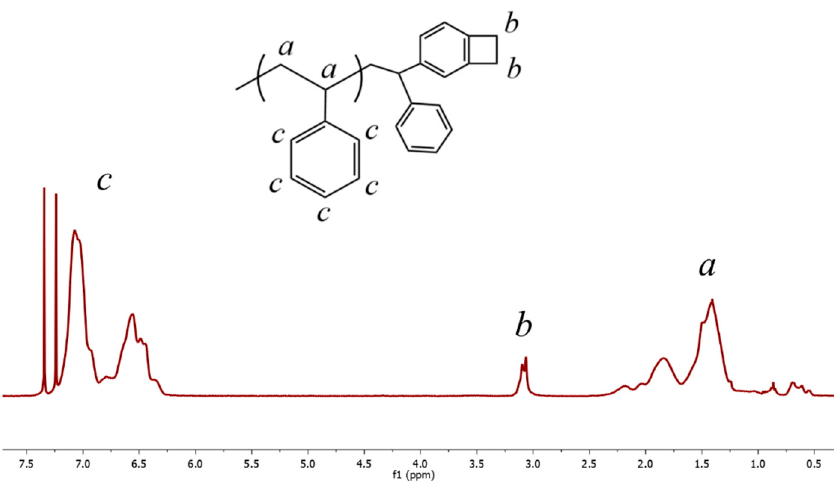
Figure 3. 1 H-NMR spectrum of DPE-CB end-capped PS.